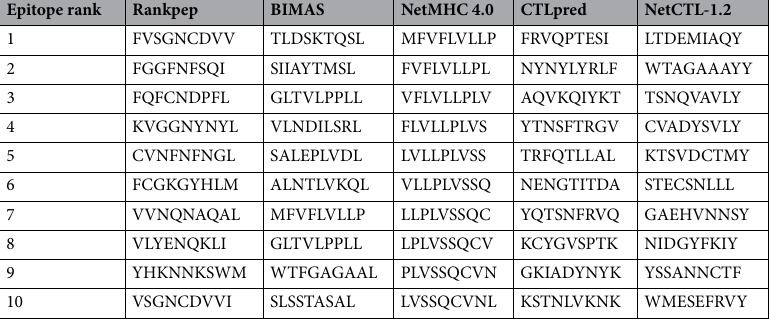
Table 1. Putative cytotoxic T-lymphocytes epitopes for the infectious sequence of coronavirus identified by employing the five different algorithms. Top ten ranked predicted epitopes from each server are depicted here.